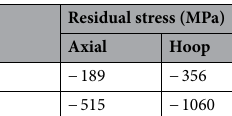
Residual stress (MPa) Axial Hoop Sample 1 − 189 − 356 Sample Table 2. Residual stresses near the surface of the tooth root of both gear samples determined by the conventional surface removal XRD method.